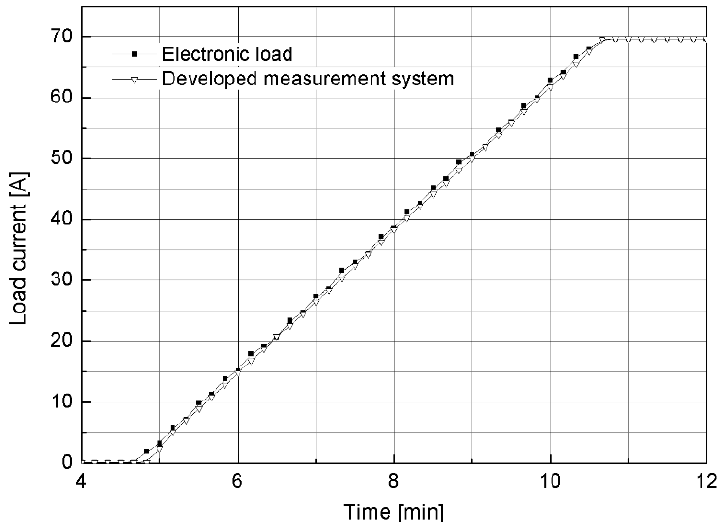
Figure 10. Start up phase of the PEMFC test